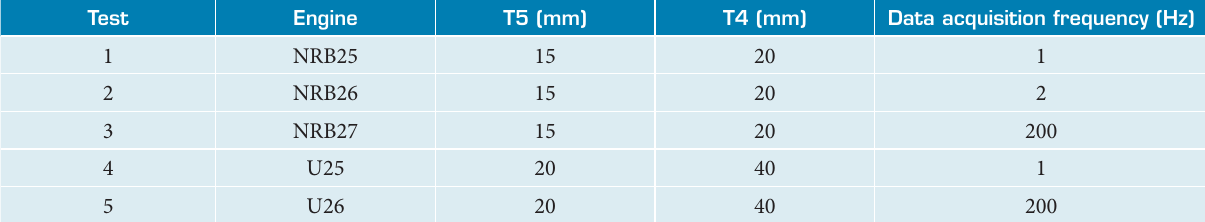
Table 5. Position of thermocouples during the static